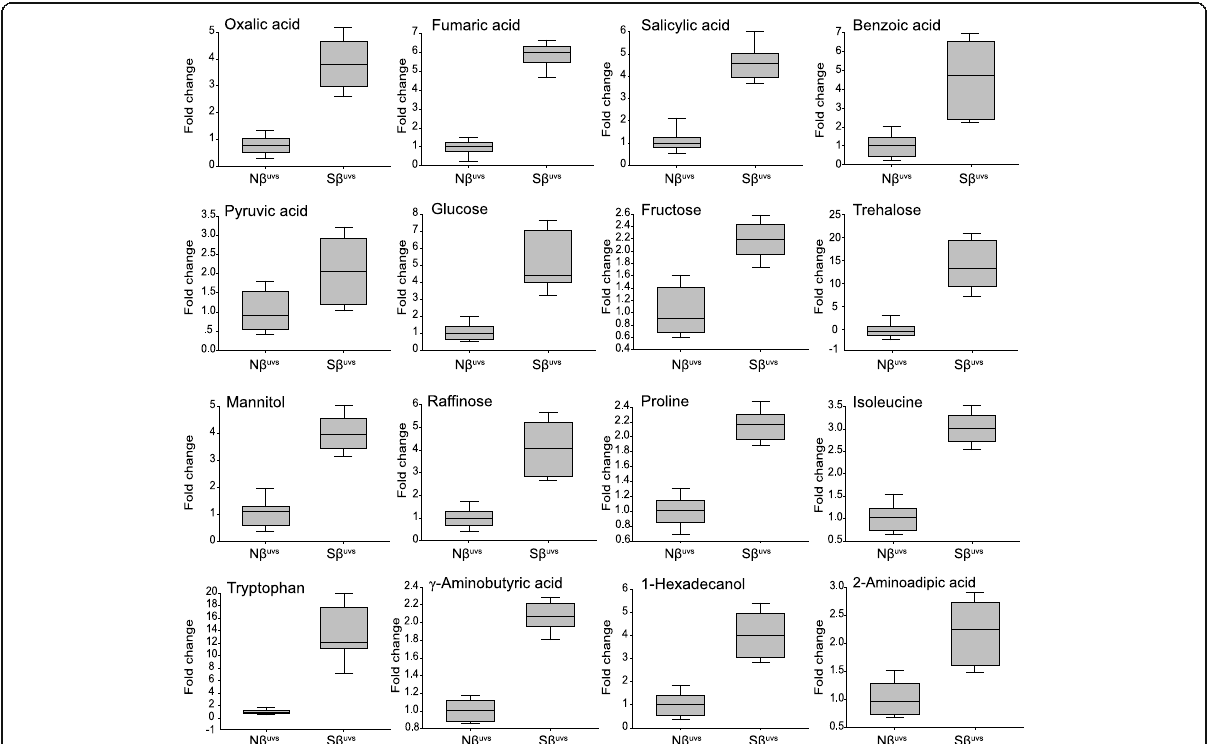
Fig. 7 Metabolite abundance of selected key metabolites in N β and S β plants after UV-B stress. Box plots showing the relative abundance of key metabolites of sugar and amino acid metabolism, GABA shunt, and tricarboxylic acid (TCA) cycle, represented as fold change in N β and S β seedlings after